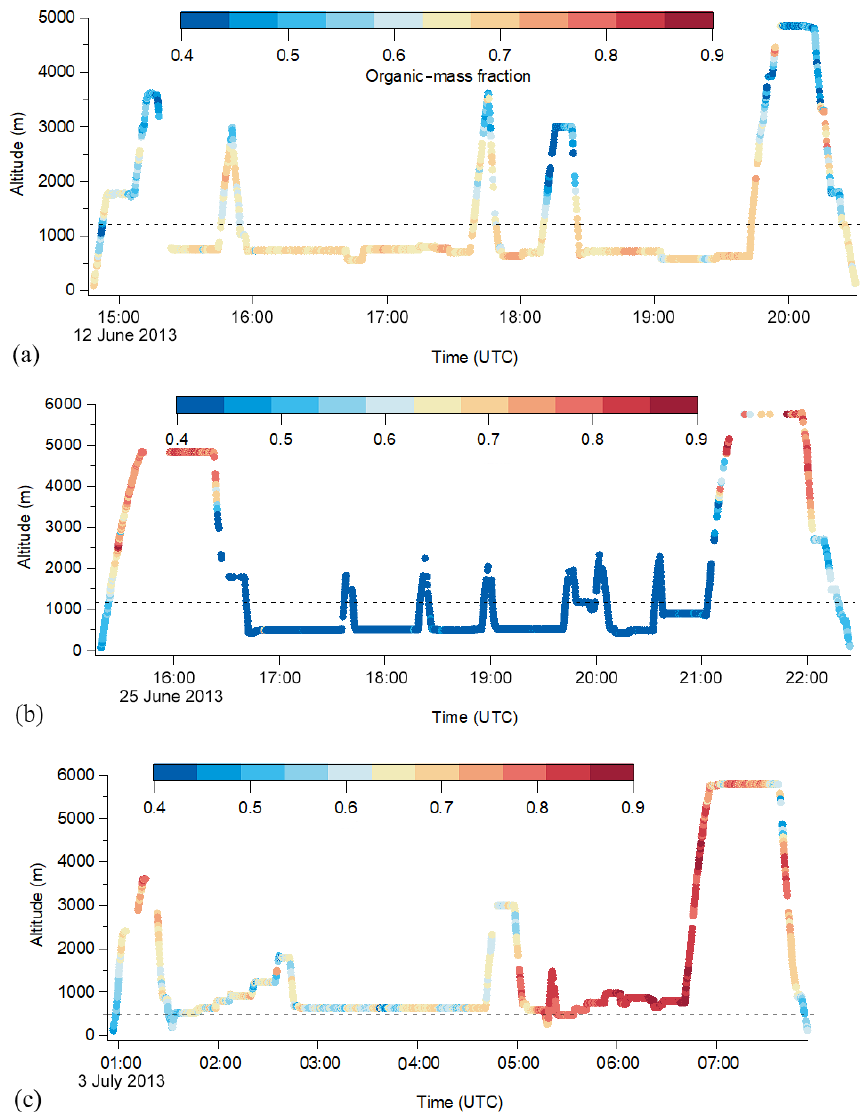
Figure 1. Altitude as a function of time (UTC) colored by organic-mass fraction. Spatial and vertical distribution of the organic-mass fraction (a) for Flight 6, (b) for Flight 12, and (c) for Flight 16, denoting the difference in chemical composition, which in turn may influence cloud droplet number concentration. The dashed line represents the boundary layer height, derived from Wagner et al. (2015) for daytime (1200m) and from Seidel et al. (2012) for nighttime